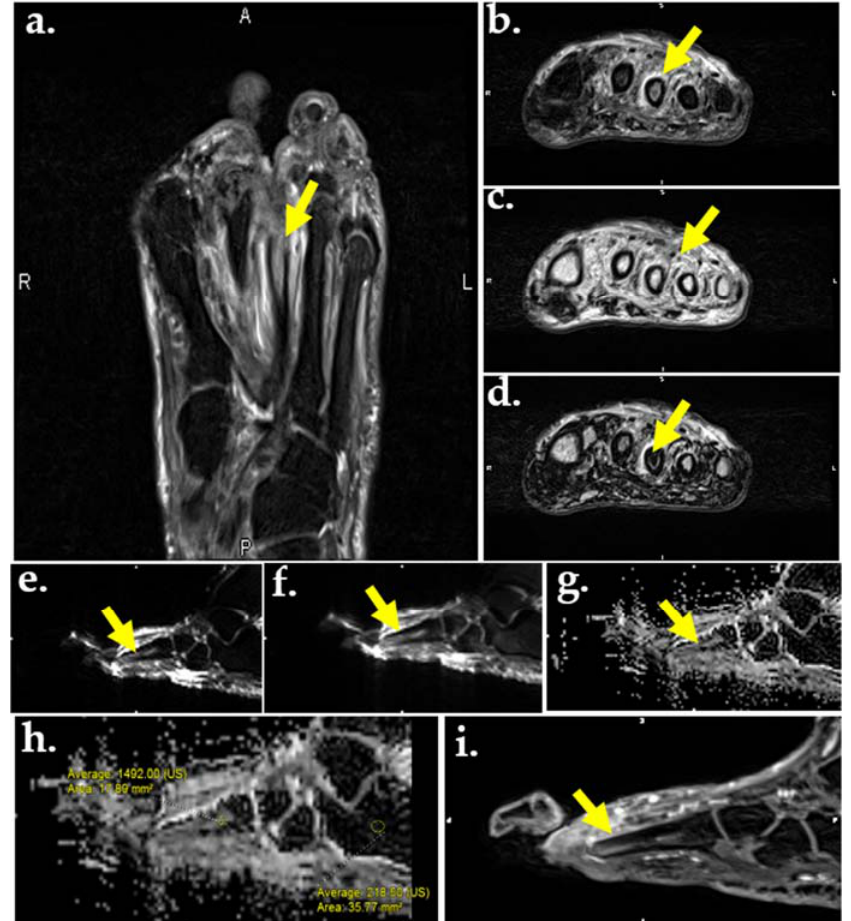
Figure 5. MR images of the foot in a 56-year-old male with DM and plantar ulcer with plantar ulcer below the 3rd metatarsal and suspected OM. Prior fracture deformity of the second metatarsal head and surgical resection of the third metatarsal are noted. T2-weighted fat suppressed image ( a ) and T2 Dixon water map ( b ) show marrow edema of the third metatarsal stump (arrows). In-phase T2 Dixon map ( c ) shows muscle fatty replacement from DM denervation change (arrow). Opposed-phase T2 Dixon map ( d ) shows marrow involvement by OM. DWI images ( e , f ) show marrow replacement by OM on low ( a ), high ( b ), and apparent diffusion coefficient (ADC) maps ( g , h ). Quantification of the marrow abnormality by ADC ( h ) measures 1.49 compared to normal marrow of 0.21, indicating no intra-osseous abscess, which would appear dark on ADC and bright on DWI. ( i ) Contrast-enhanced MR shows enhancement of the metatarsal